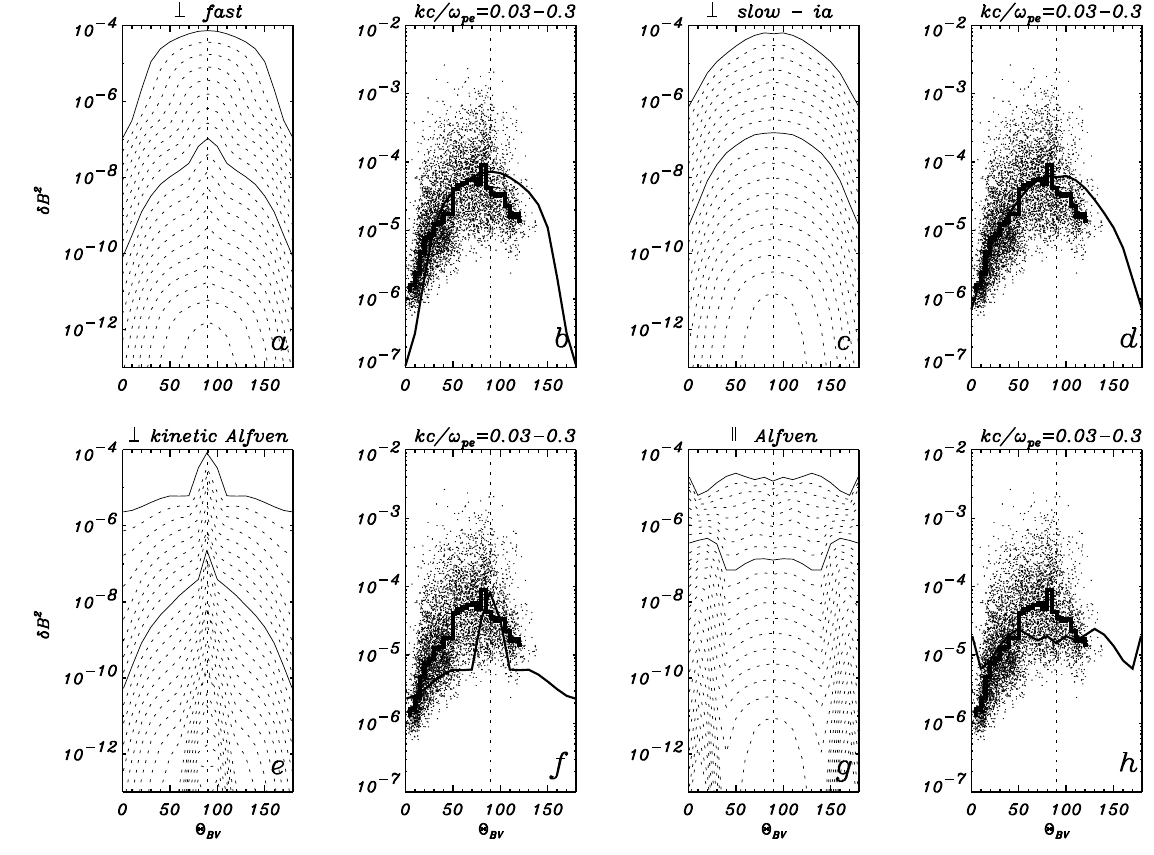
δB 2 ( f, Θ BV ) Figure7:Themodel (Eq.4),parametersandobservationsoftheday Fig. 7. The model δB 2 (f,2 BV ) (Eq. 4), parameters and observations on 19 December 2001. For kc/ω pe ’ 0.3 to 30, the fluctuations suffer a pure Doppler shift, with I 3 D ( k ) given by Eqs. (5) and (7), ν =3 to 4 and µ =100. For larger scales ( kc/ω pe ’ 0.03 to 0.3), different (Doppler shifted) dispersion relations and different wave vector distributions are considered. Quasi-perpendicular fast mode (Eqs. 7 and 8): (a) the model δB 2 (2 BV ) at the STAFF-SA frequencies, from 8.8Hz (upper solid line) to 561Hz (lower dotted line); arbitrary ordinates; (b) the model at 8.8Hz (solid line) compared to the scatter plot and the median of the observations at the same frequency, as a function of 2 BV . Quasi-perpendicular slow-ion acoustic mode (Eqs. 7 and 9): (c) the model δB 2 (2 BV ) at different frequencies; (d) the model at 8.8Hz compared with the observations. Quasi-perpendicular Alfv´en waves in the kinetic range (Eqs. 7 and 11): (e) the model δB 2 (2 BV ) at different frequencies; (f) the model at 8.8Hz compared with the observations. Quasi-parallel Alfv´en waves (Eqs. 6 and 11): (g) the model δB 2 (2 BV ) at different frequencies; (h) the model at 8.8Hz compared with the